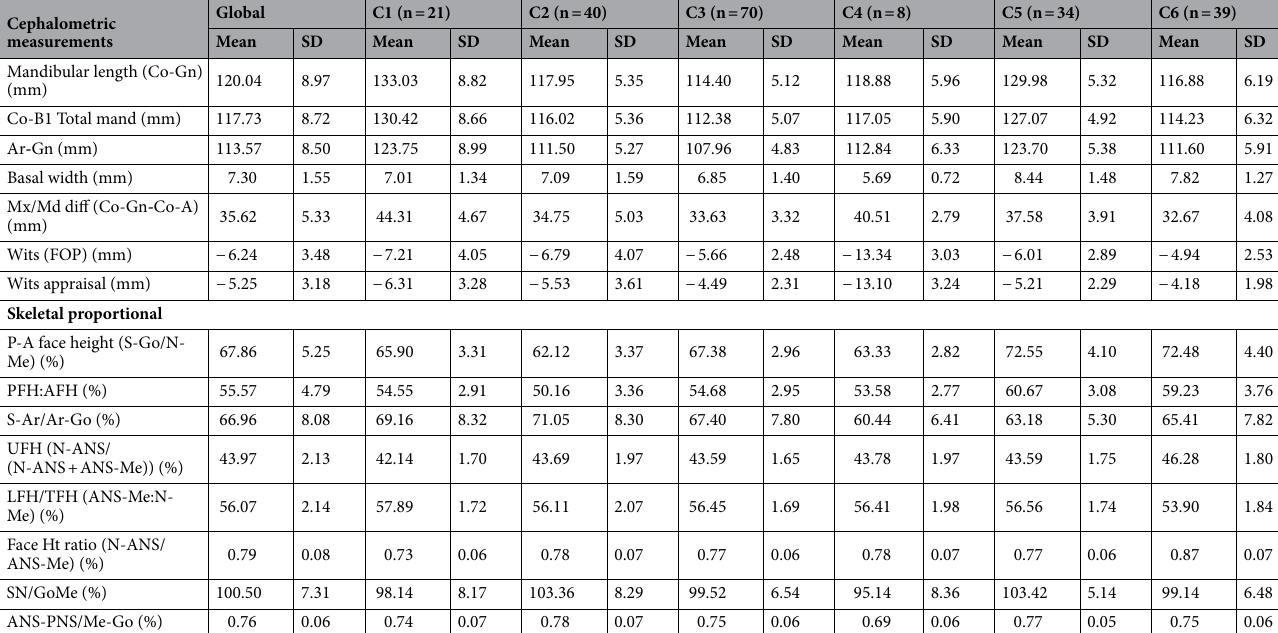
Table 3. Craniometric mean values defined in each skeletal cluster. SD standard